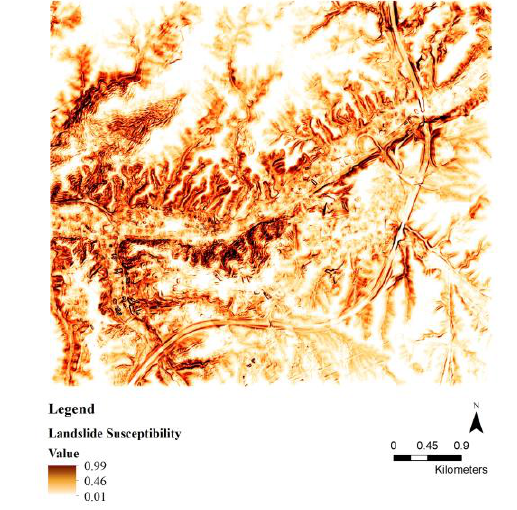
Figure 15. Landslide susceptibility map of the study area